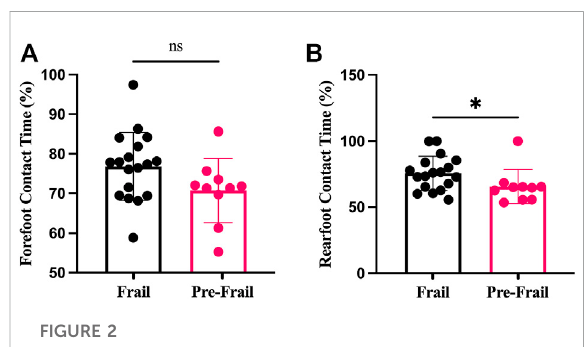
FIGURE 2 Plantar contact time; (A) forefoot contact time; (B) rearfoot contact time; ns: non-signi fi cant; *: p <